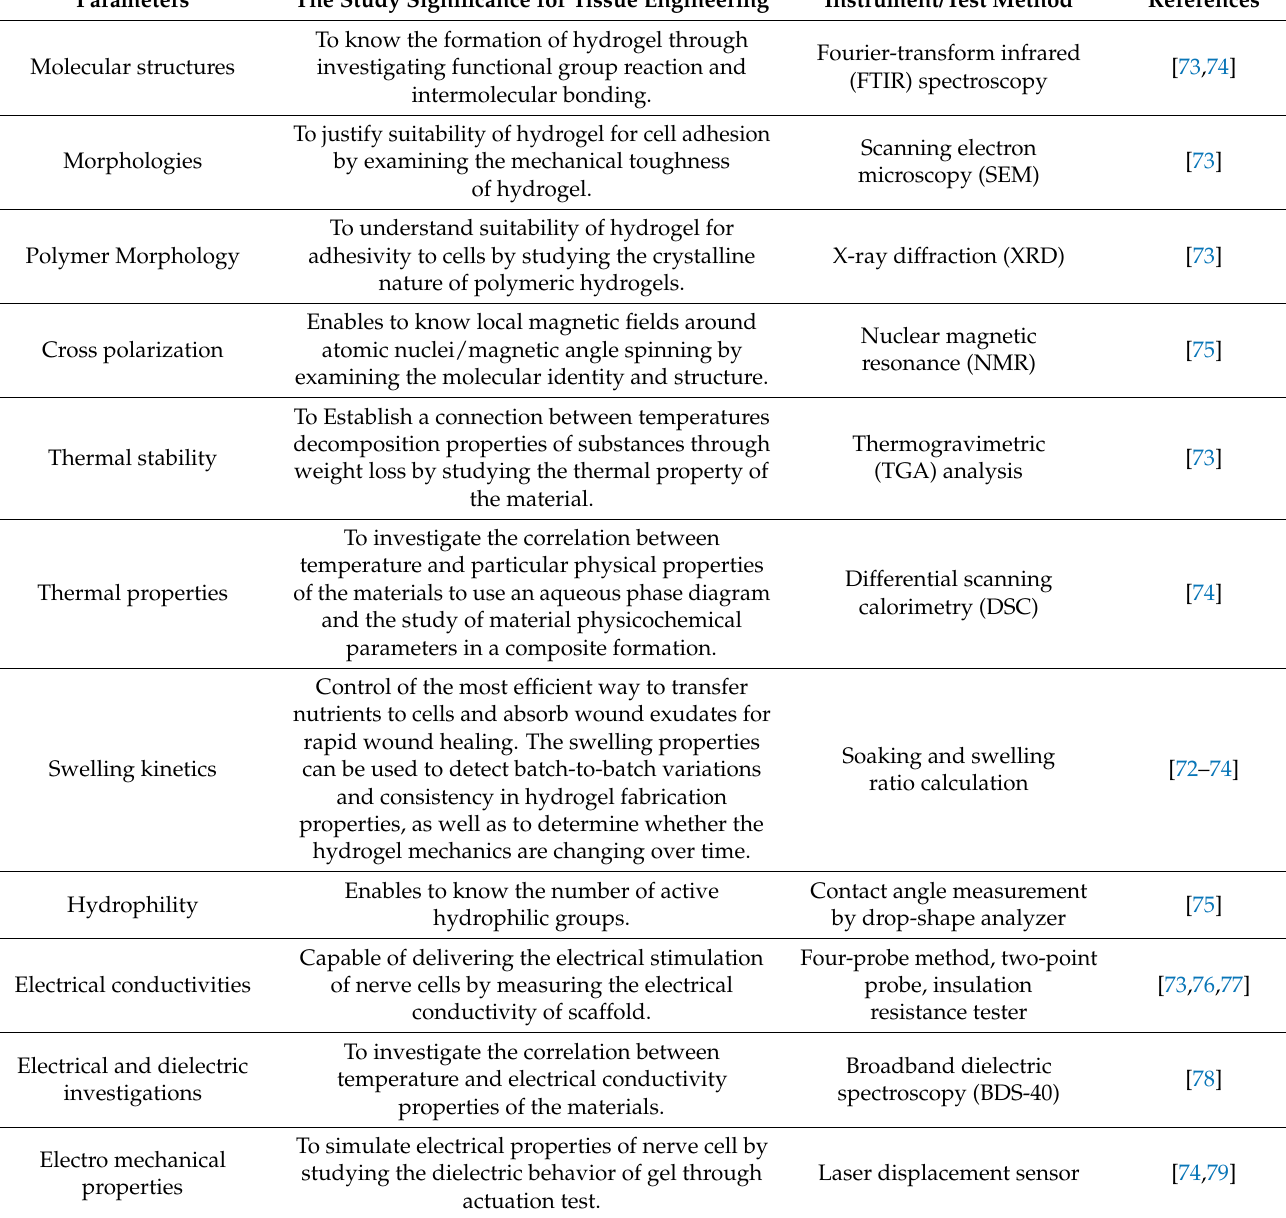
Table 2. Design parameters consideration and characterization of hydrogel scaffolds for electro- active